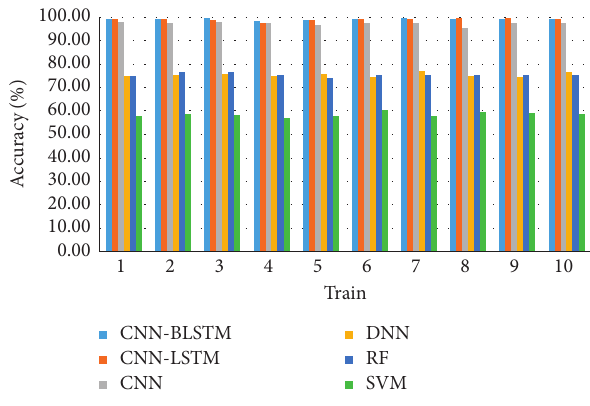
Figure 9: Test results. Table 7: Test results by different methods.